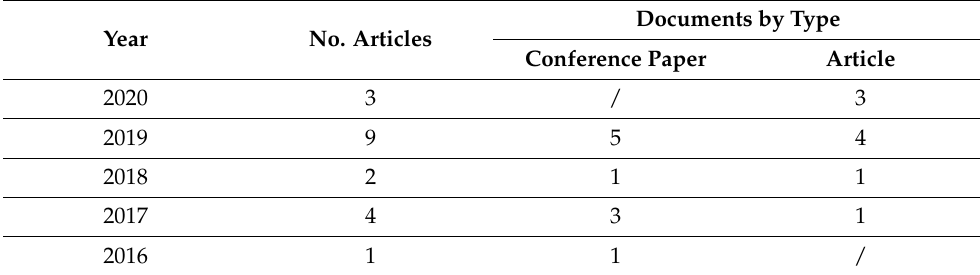
Table 1. Documents by year and type (source: Scopus).